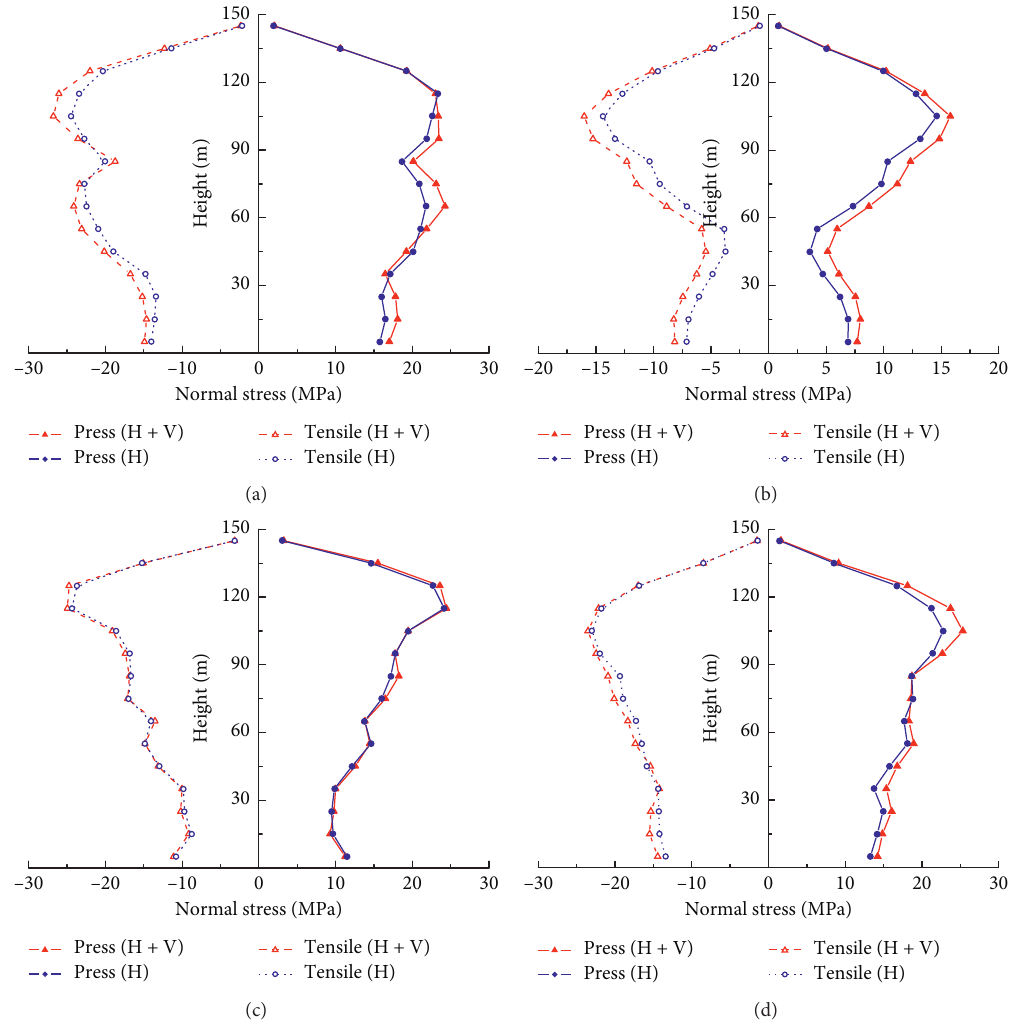
Figure 11: Spatial distributions of maximum earthquake normal stresses at different cross sections for the 150m high chimney under two types of seismic load applied for each of the four earthquake wave actions: (a) Landers wave (No. 1); (b) Loma Prieta wave (No. 2); (c) Borrego wave (No. 3); (d) Chichi wave (No.